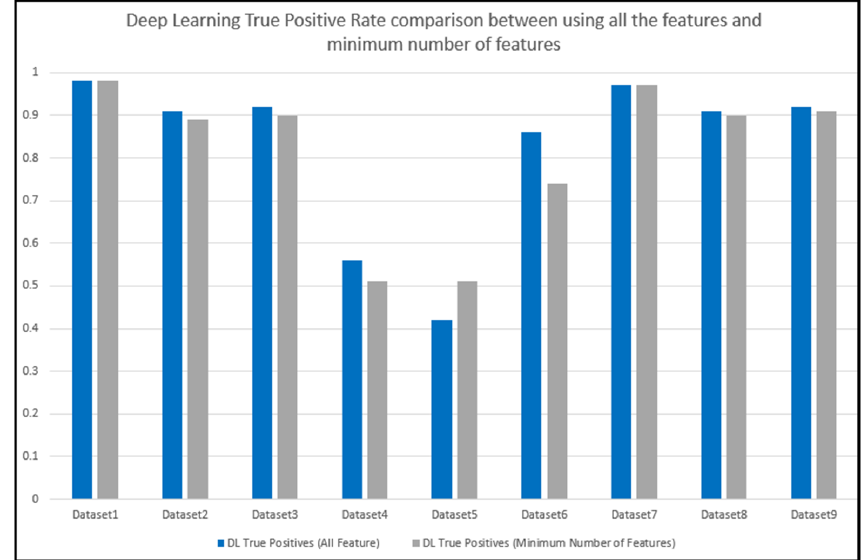
Figure 9. Zeus prediction results when tested using the minimum number of features.